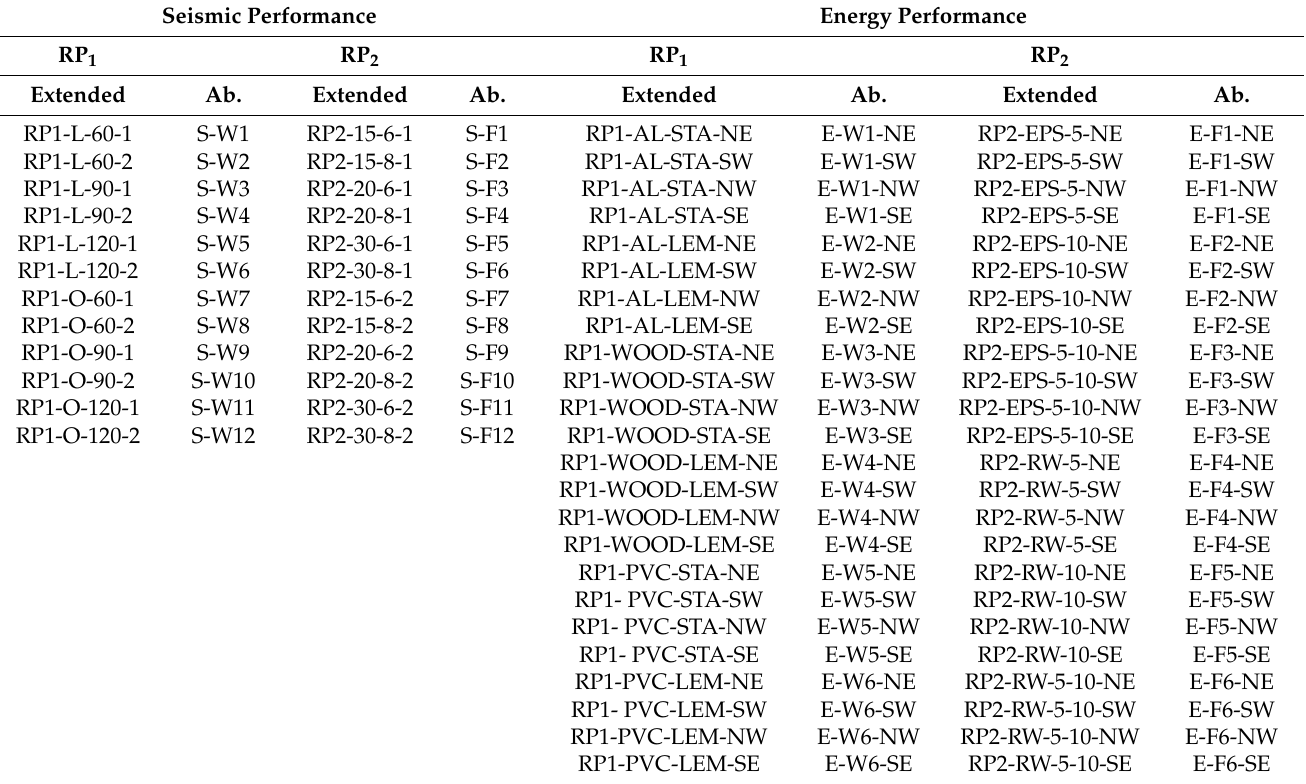
Table 5. Models defined for the sensitivity analysis.